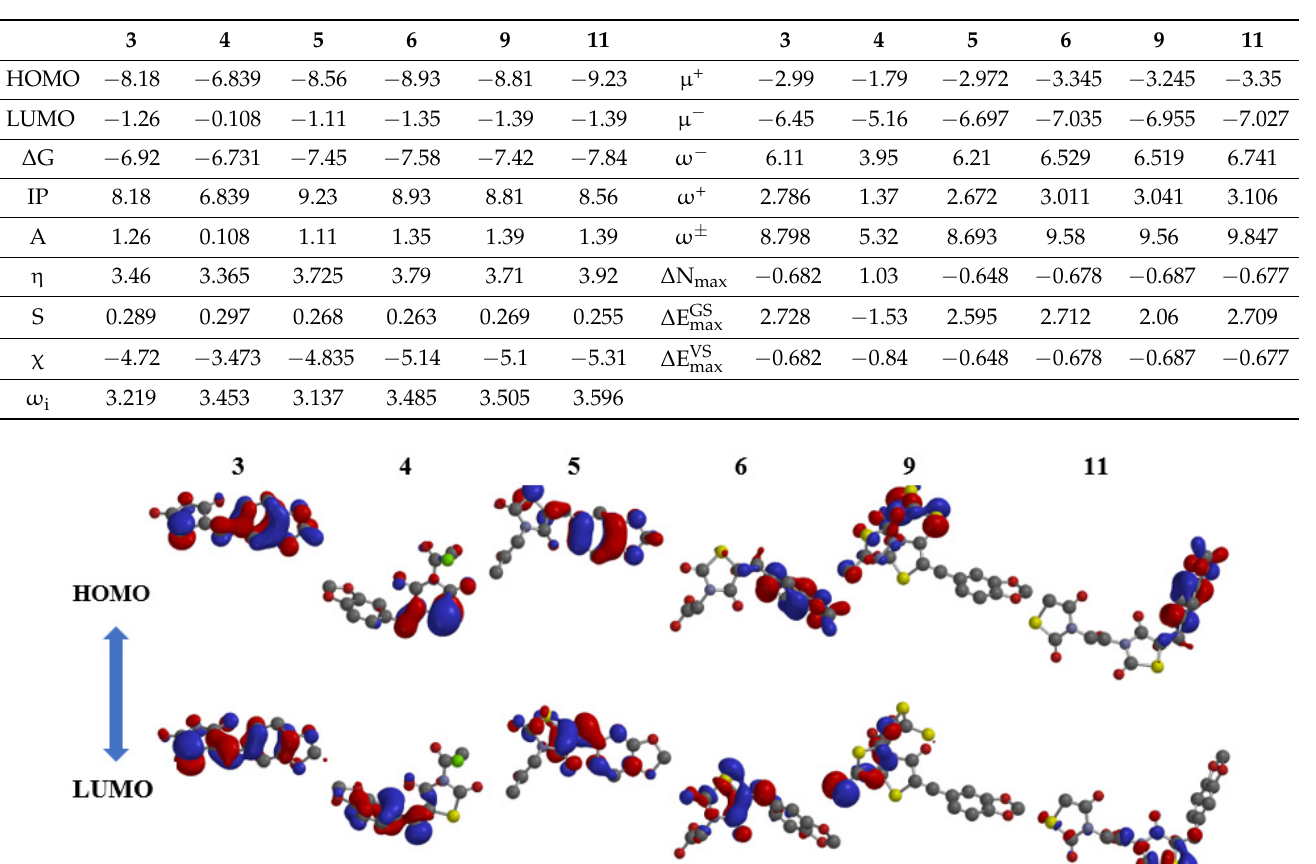
Table 1. Calculated energetic reactivity parameters for compounds ( 3 , 5–12 ) at DFT with B3LYP \ 6-311G * Basics set.